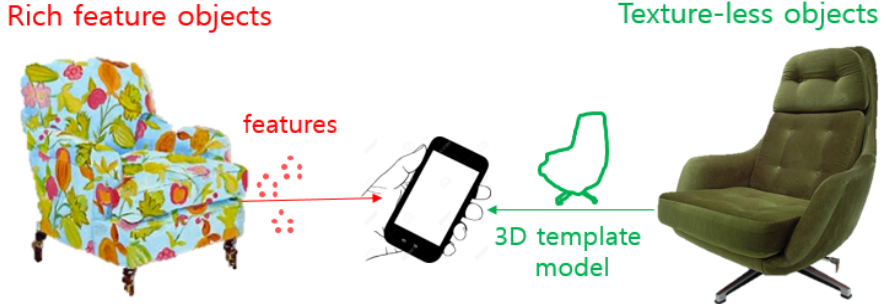
Figure 10. Guided AR tracking considering object characteristics [1].